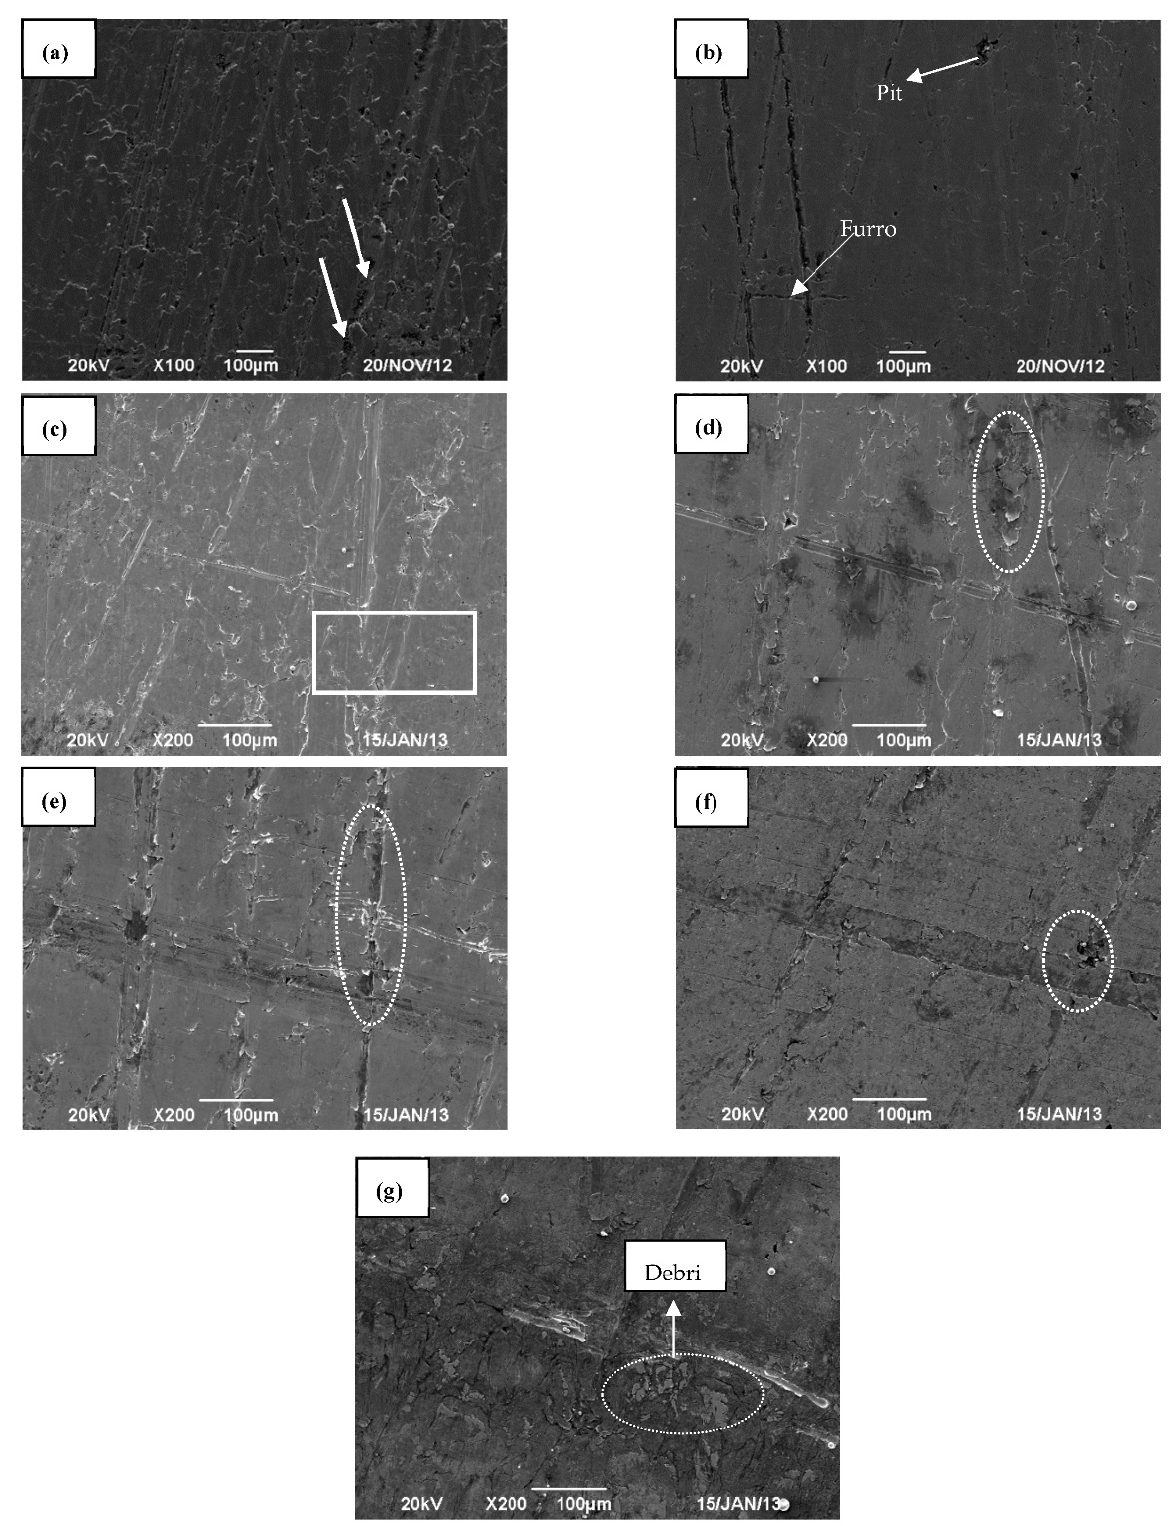
SEM images. Figure 5b illustrates the surface morphology of the cylinder liner after it was tested with pure EBF.